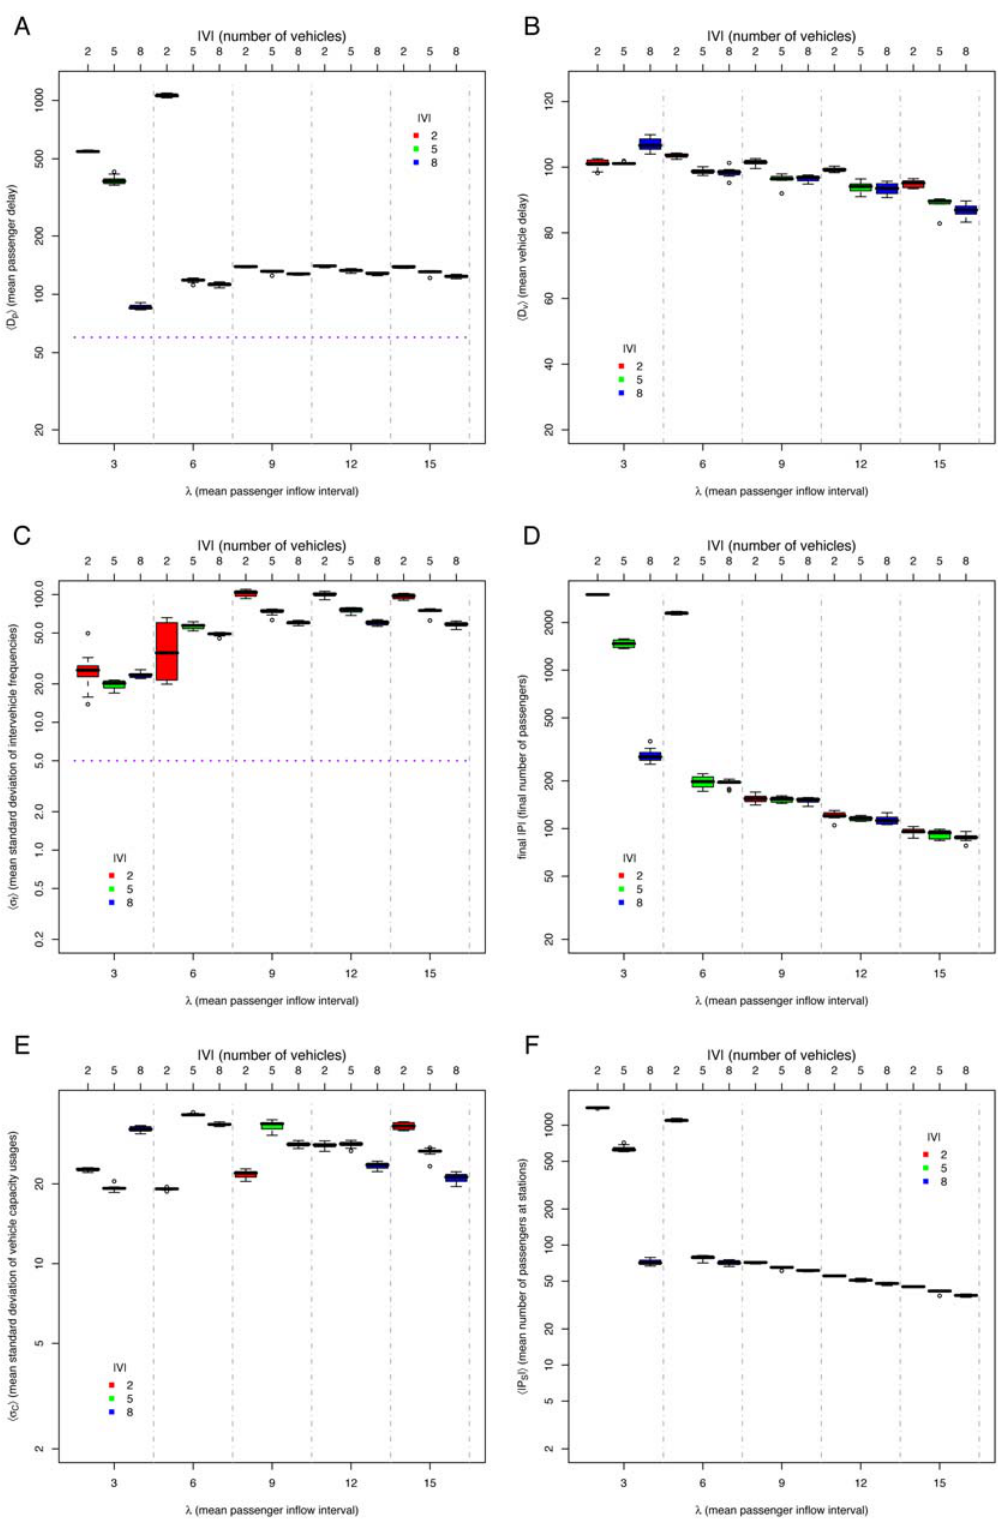
Figure 9. Simulation results for default method , varying mean passenger inflow intervals l (lower x axis, separated by vertical dashed lines) and number of vehicles V j j (upper x axis, also indicated by color of boxes): (A) mean passenger delay S D p T (data above horizontal dotted line indicates poor system performance), (B) mean vehicle delay S D v T , (C) mean standard deviation of intervehicle frequencies S s f T (data above horizontal dotted line implies unstable headways), (D) final number of passengers P j j , (E) mean standard deviation of vehicle capacity usage S s C T , and (F) mean number of passengers at stations S P s j j T .